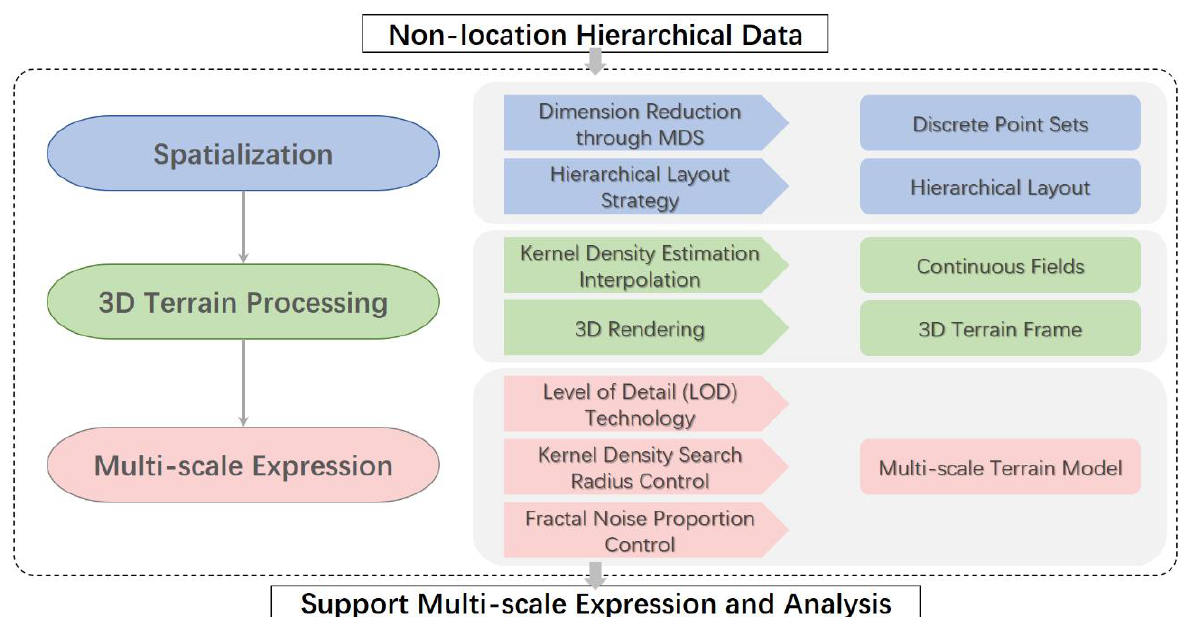
Figure 1. Methodological